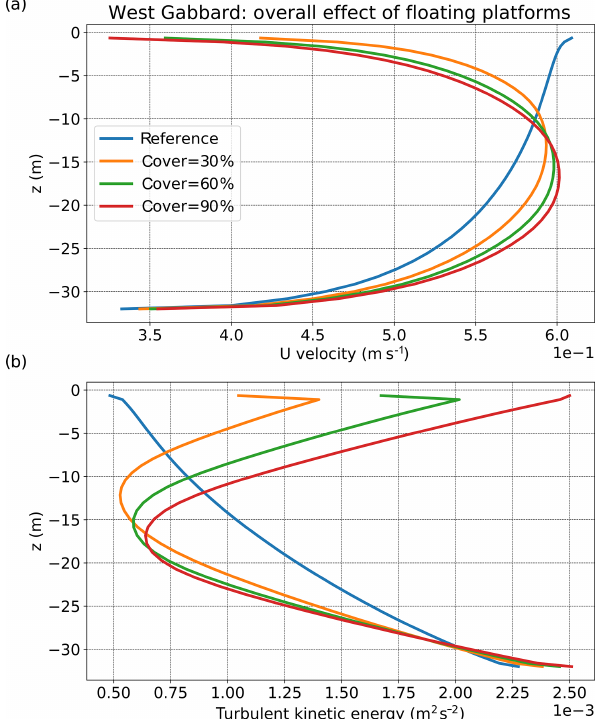
Figure 7. (a) Vertical profiles of velocity and (b) turbulent kinetic energy (averaged over 1998–2008) for the location of West Gab- bard. The results are presented for different scenarios of coverage under the overall effect of floating